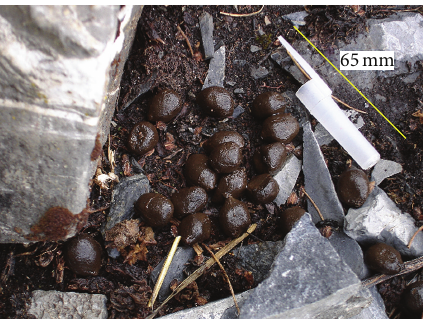
Figure 3: Pellet group collected in the field, only one was later selected by chance. The pen cap is displayed for size comparison.